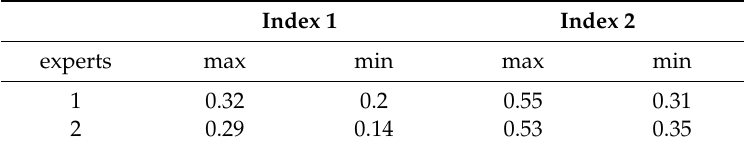
Table 3. Marking of